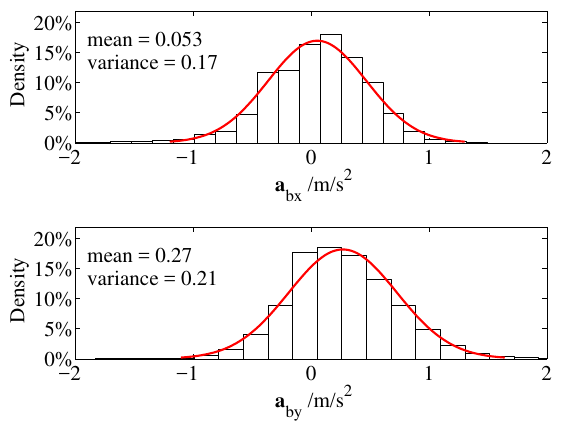
Figure 18. Distributions of IMU data.